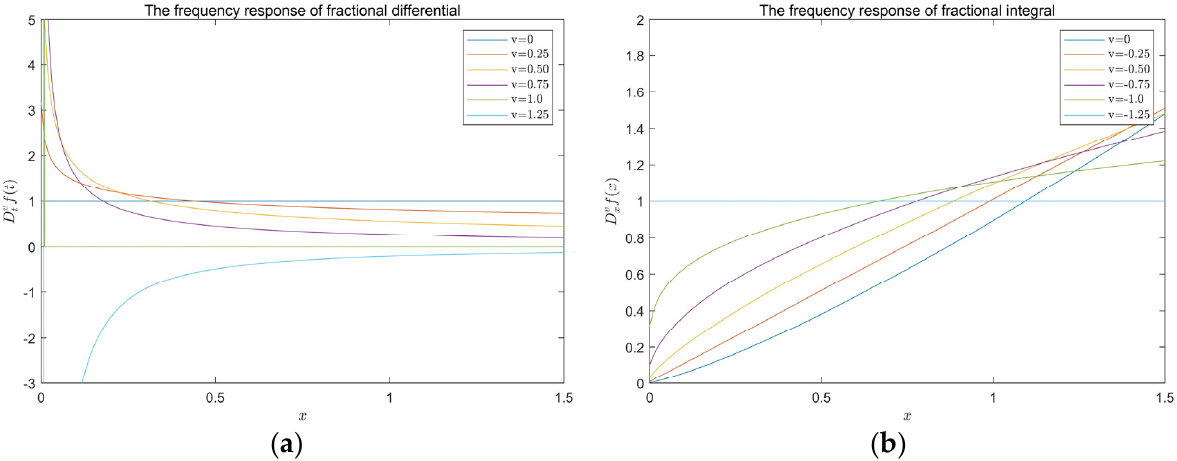
Figure 1. Amplitude − frequency characteristic curve of fractional calculus. ( a ) Fractional differential amplitude − frequency characteristic curve and ( b ) fractional-order integral amplitude-frequency characteristic curve.